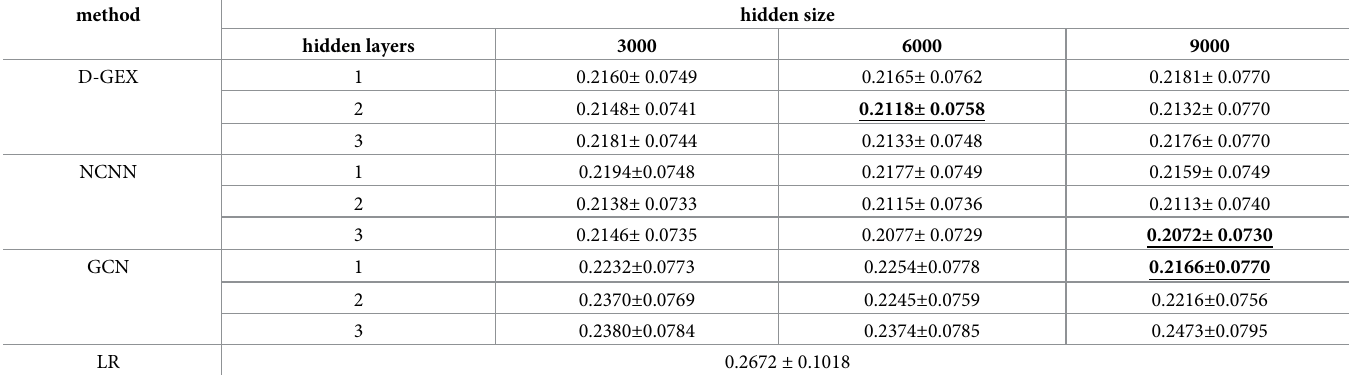
Table 3. MAE comparison between D-GEX and NCNN model in the prediction of GTEx data when varying the number of hidden layers and hidden size.